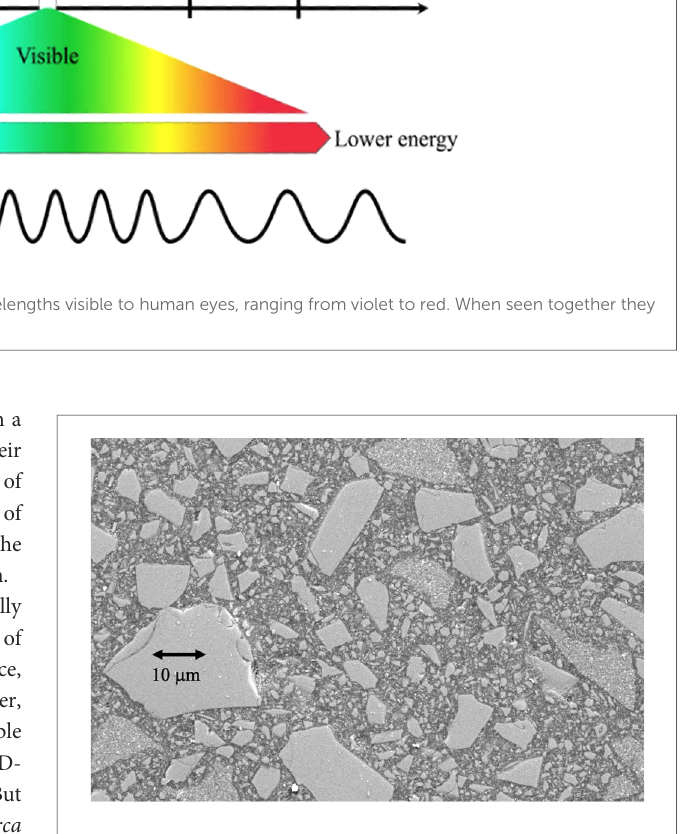
FIGURE 2 Scanning electron microscope image of a representative contemporary resin-based BF composite. The larger incorporated particles (>10 µm) are themselves fragmented chips of pre-polymerised composite, rather than solid inorganic powder particles. These pre-polymerised particles allow for fi nishing and polishing after placement to a high